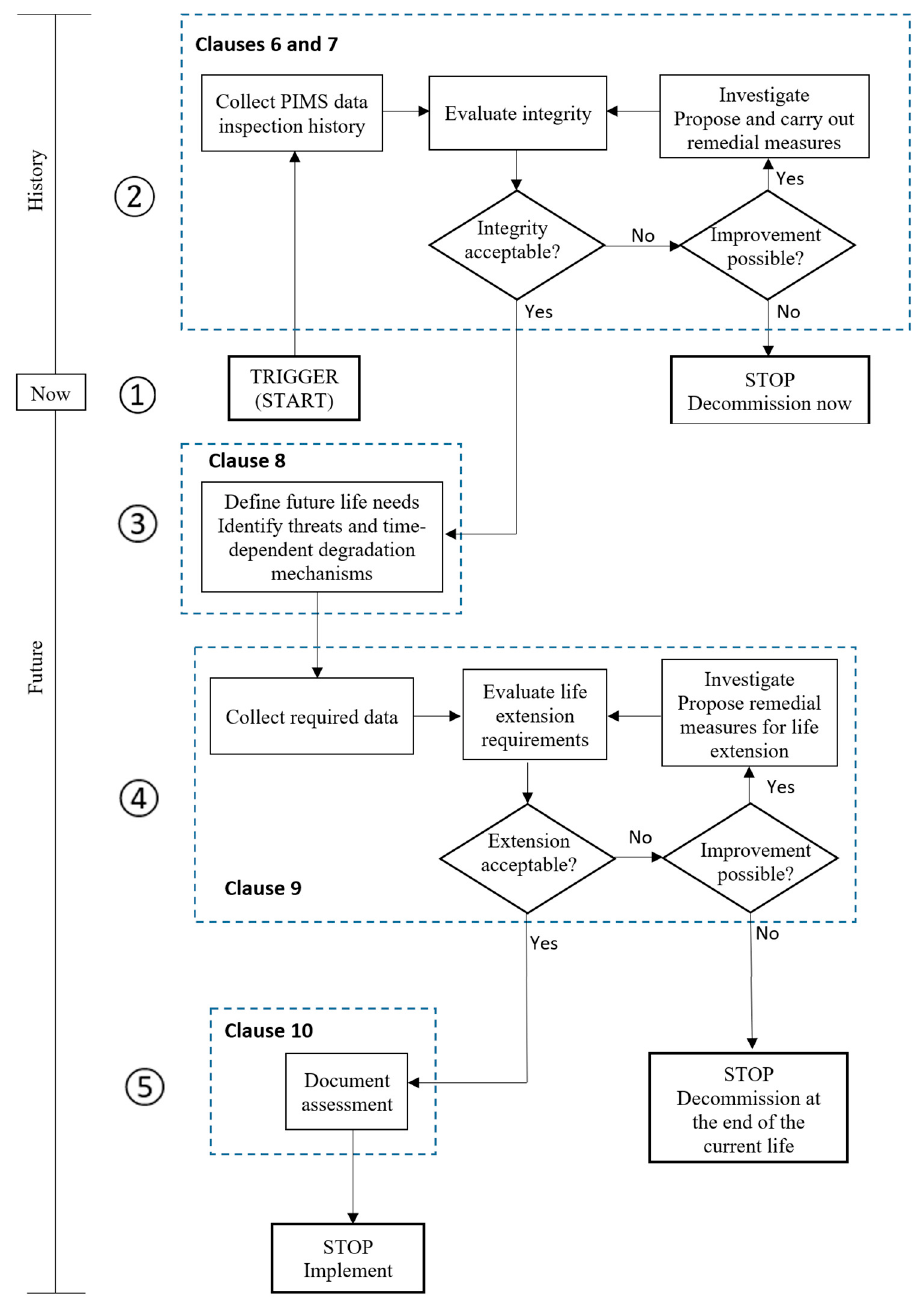
Figure 10. The life extension process in